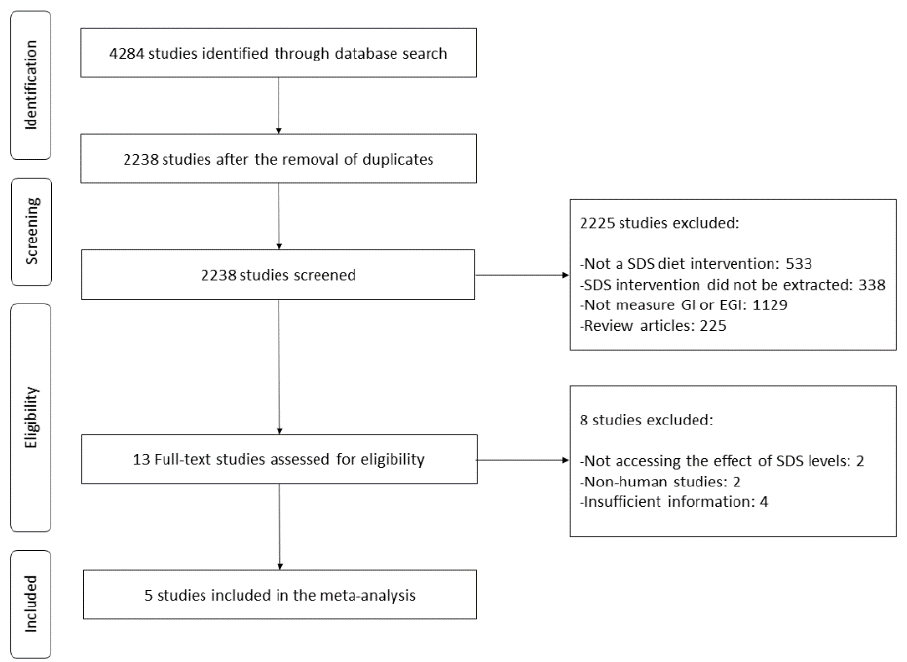
Figure 1. Flow chart of study selection for the meta-analysis.